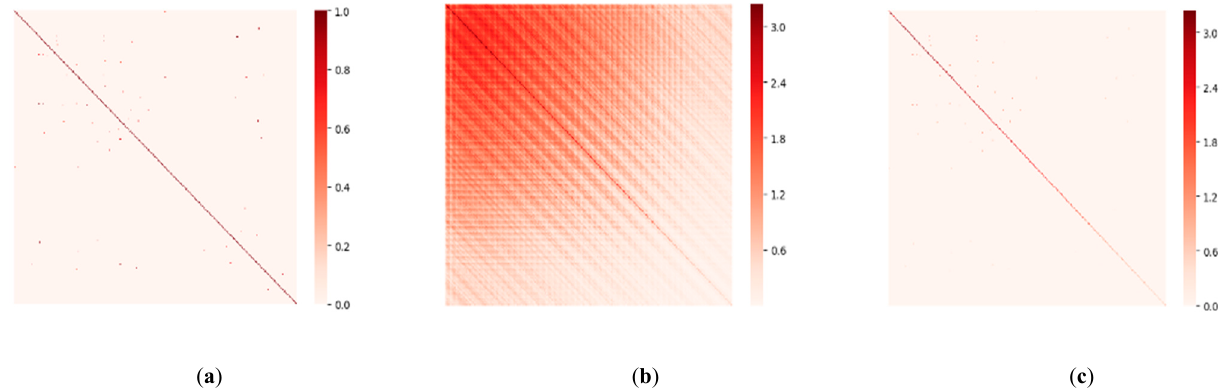
Figure 7. Different adjacency matrices in PeMSD4. ( a ) Distance adjacency matrix. ( b ) Covariance adjacency matrix. ( c ) Dynamic adjacency matrix.